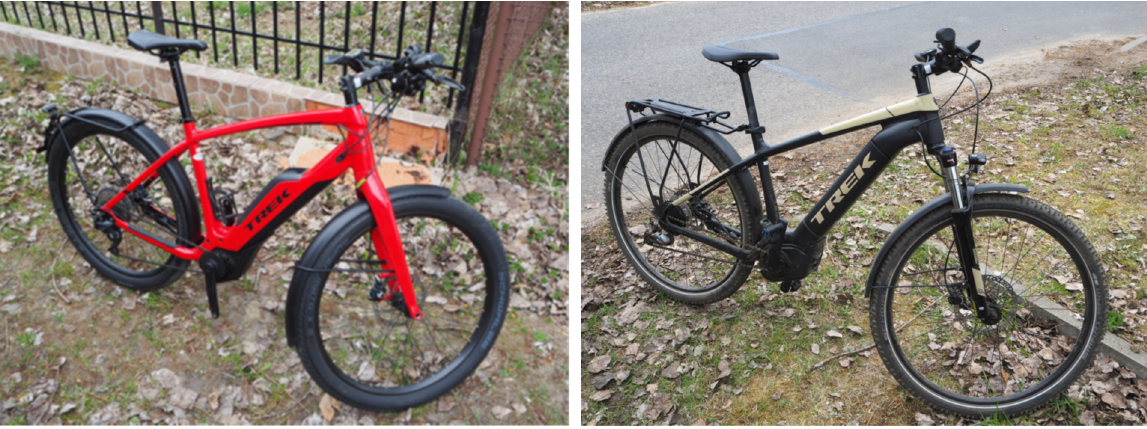
Figure 1. The bikes used for the tests.